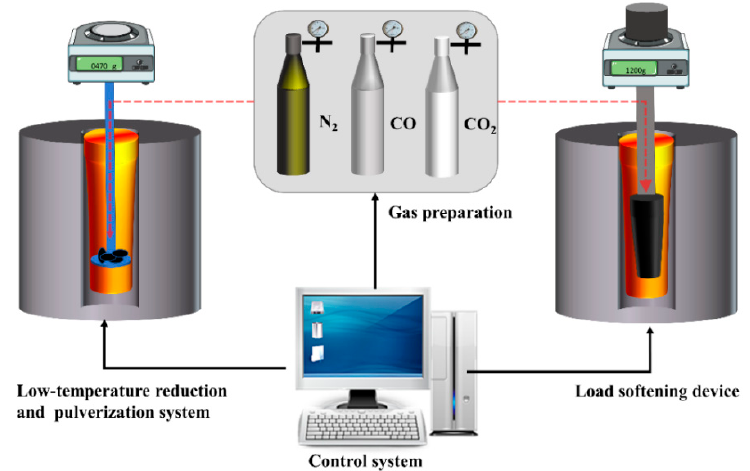
Figure 2. Schematic diagram of the metallurgical performance experimental device.